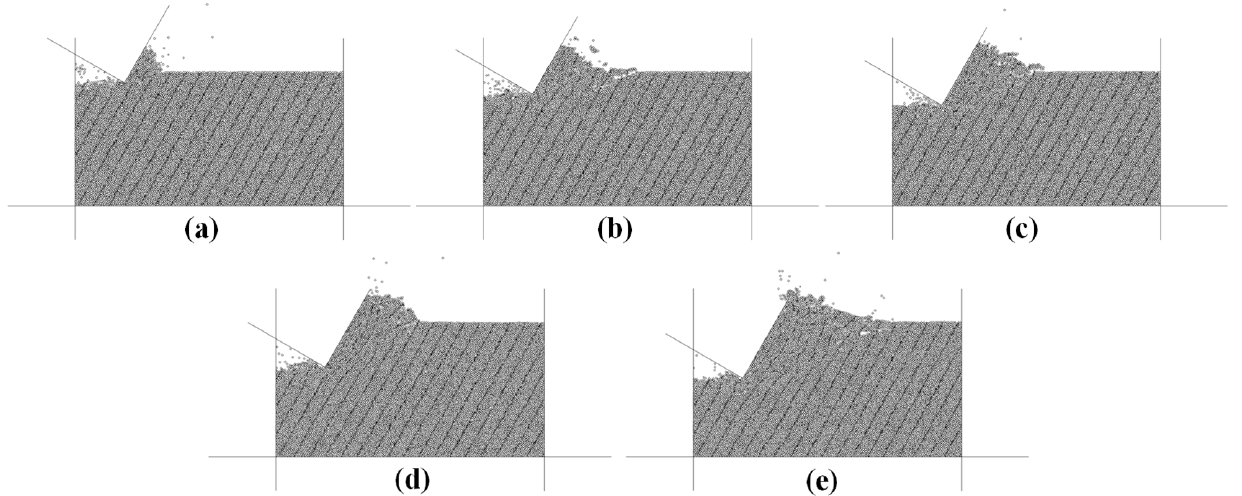
Figure 14. Cutting failure of numerical specimens with different cutting depths: ( a ) 5 mm; ( b ) 10 mm; ( c ) 15 mm; ( d ) 20 mm; ( e ) 25 mm.